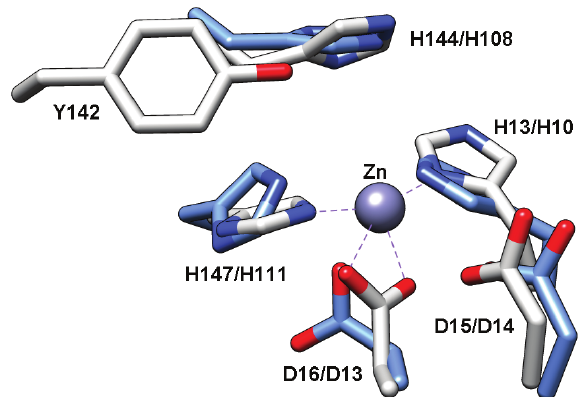
Figure 7. Overlay of TT1542 (blue, PDB 1UAN) with MshB (gray, PDB 4EWL). The Zn 2+ bound to MshB is represented as a gray sphere. The numbering corresponds to